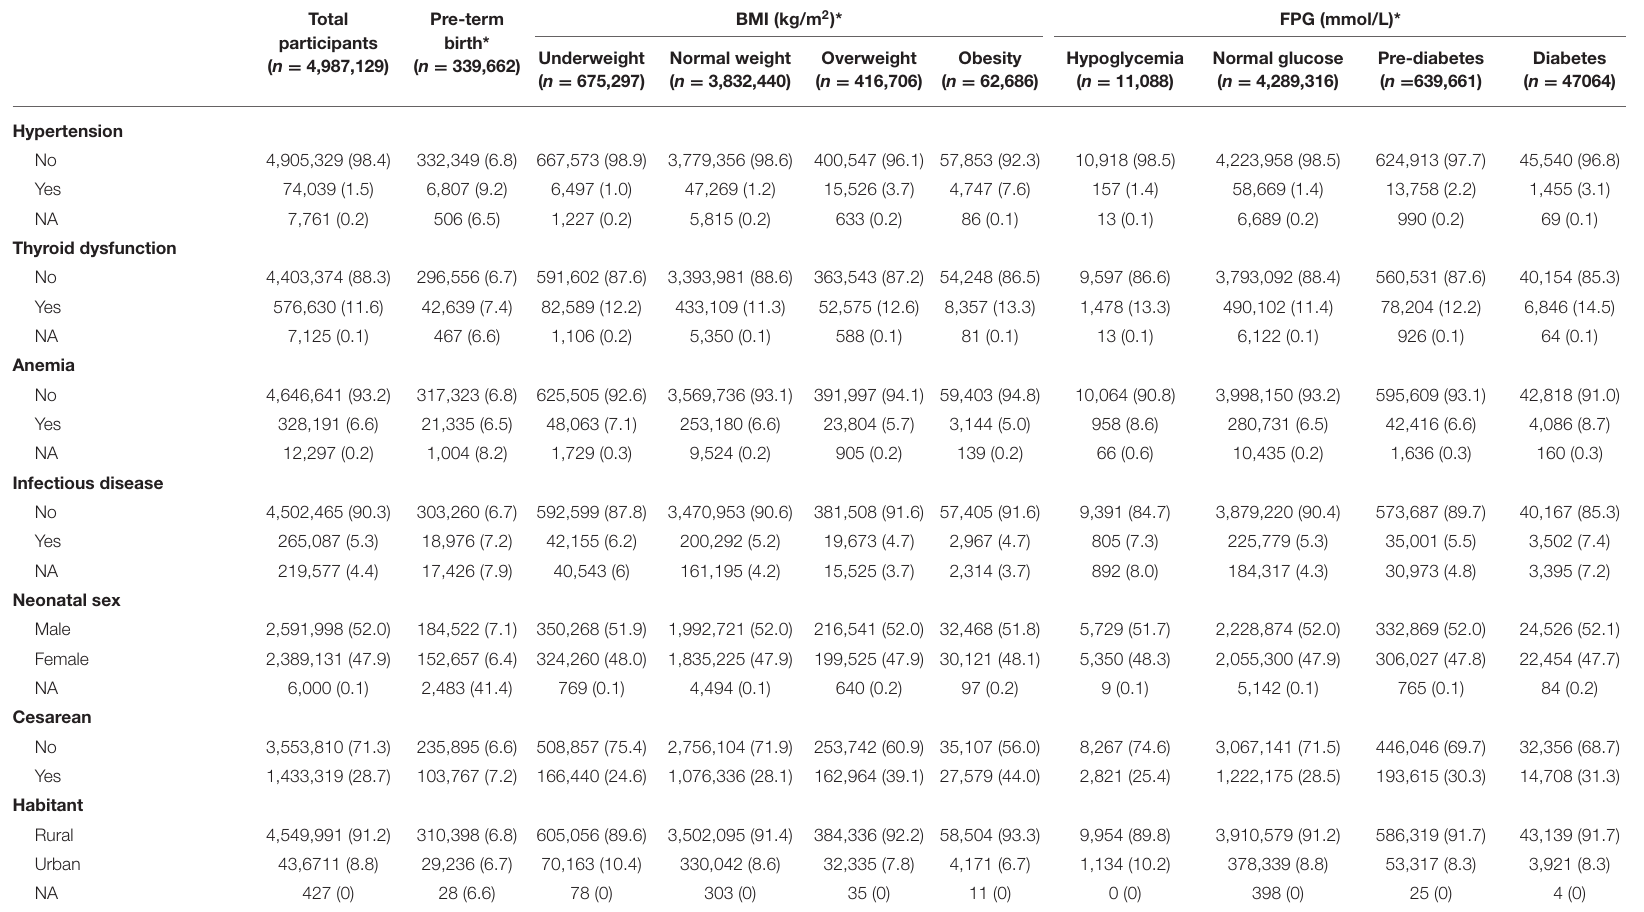
a Adverse pregnancy history included history of spontaneous abortion, stillbirth, pre-term birth, or induced abortion. * The group differences between pre-term birth and term birth, BMI groups or FPG groups, with respect for the baseline characteristics were all statistically significant (p < 0.05), except for neonatal sex in BMI groups or FPG groups and smoking in FPG groups (p > 0.05). BMI, body mass index; FPG, fasting plasma glucose. Underweight (BMI < 18.5 kg/m 2 ); normal weight (BMI 18.5–24.9 kg/m 2 ); overweight (BMI 25.0–29.9 kg/m 2 ); obesity (BMI ≥ 30.0 kg/m 2 ); hypoglycemia (FPG ≤ 2.7 mmol/L);